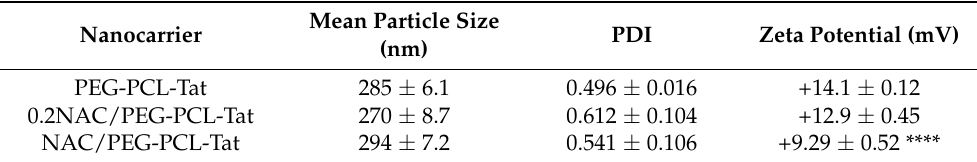
Table 2. Particle diameter, PDI, and zeta potential of PEG-PCL-Tat, 0.2NAC/PEG-PCL-Tat, and